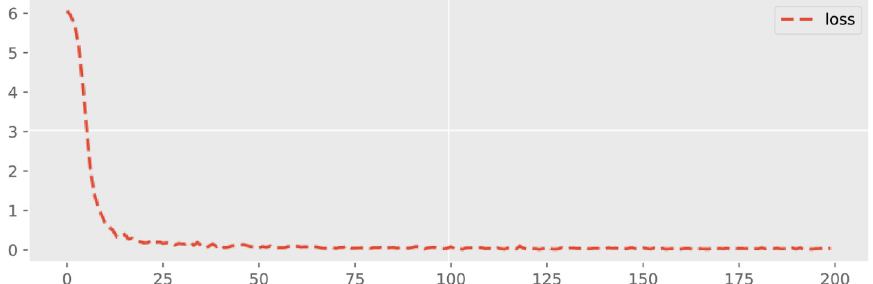
Fig 10. Validation loss across 200 epochs for Offshore Windfarm 2 based on adopted fine-tuned forecasting settings.